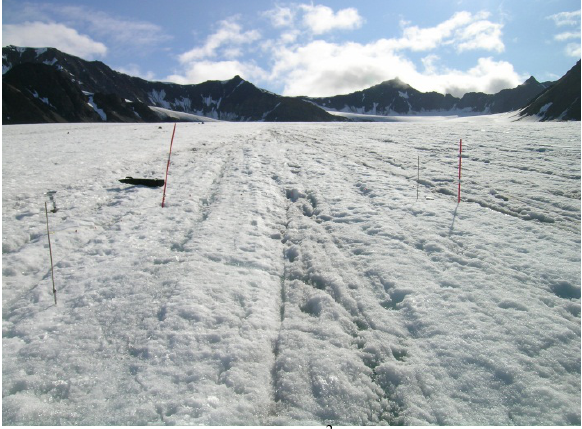
Figure 1. One of the 25 m 2 area